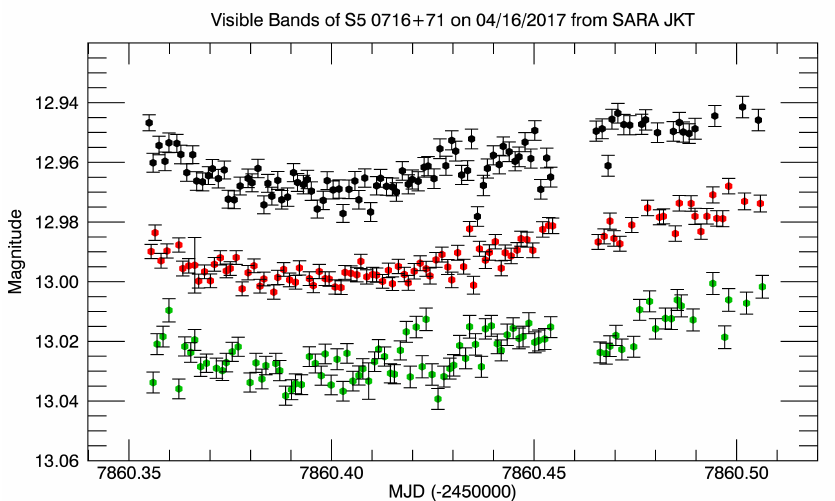
Figure 3. The SARA JKT observations. The V data (black) is offset by − 0.571 and the I data (green) by + 0.04882. Due to lack of substantial variability, the spectral index variability cannot be